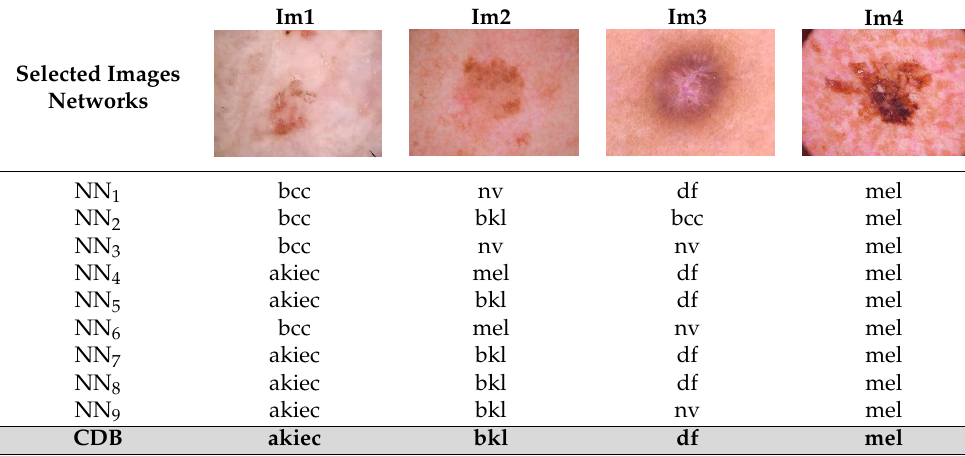
Table 4. Experimental results in the case of four randomly selected images.